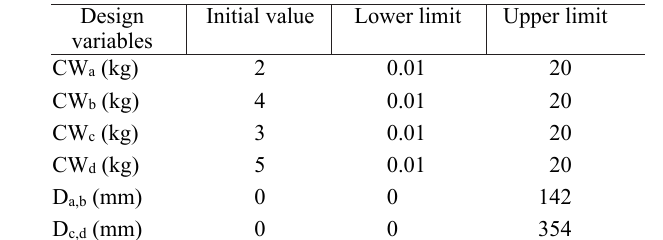
Table 4. System design